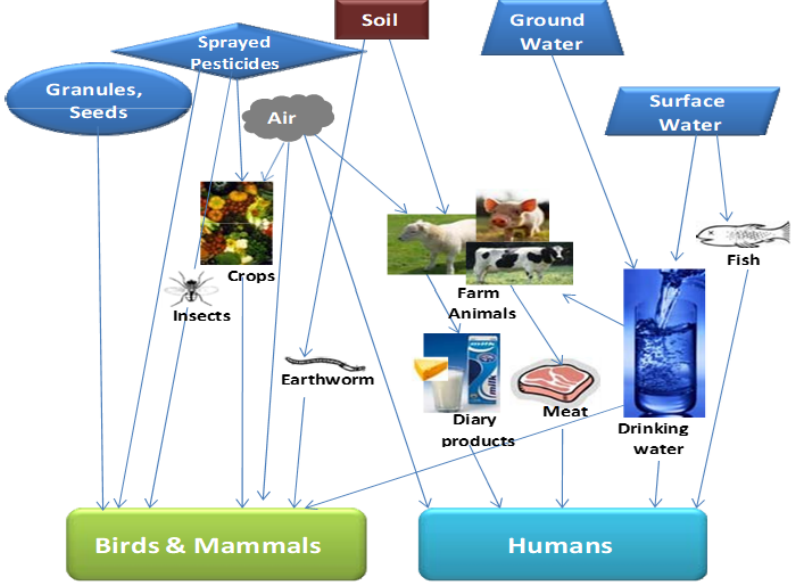
Figure 4. A schematic of the impact of organophosphate pesticides on humans and the environment. Reprinted/adapted with permission from Ref. [18].